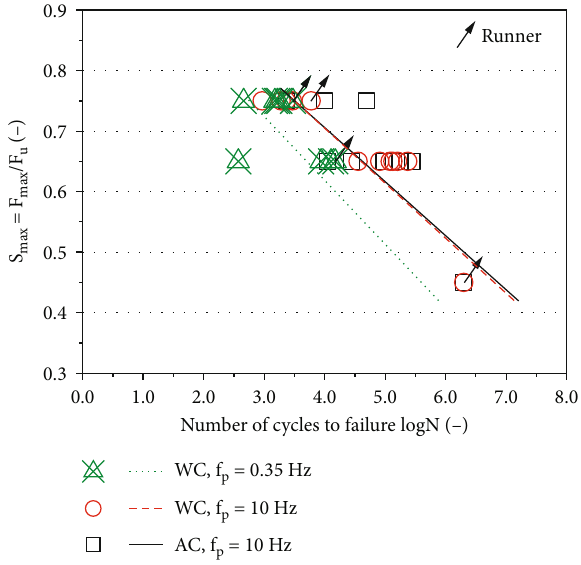
Figure 3: Fatigue test results and regression lines.